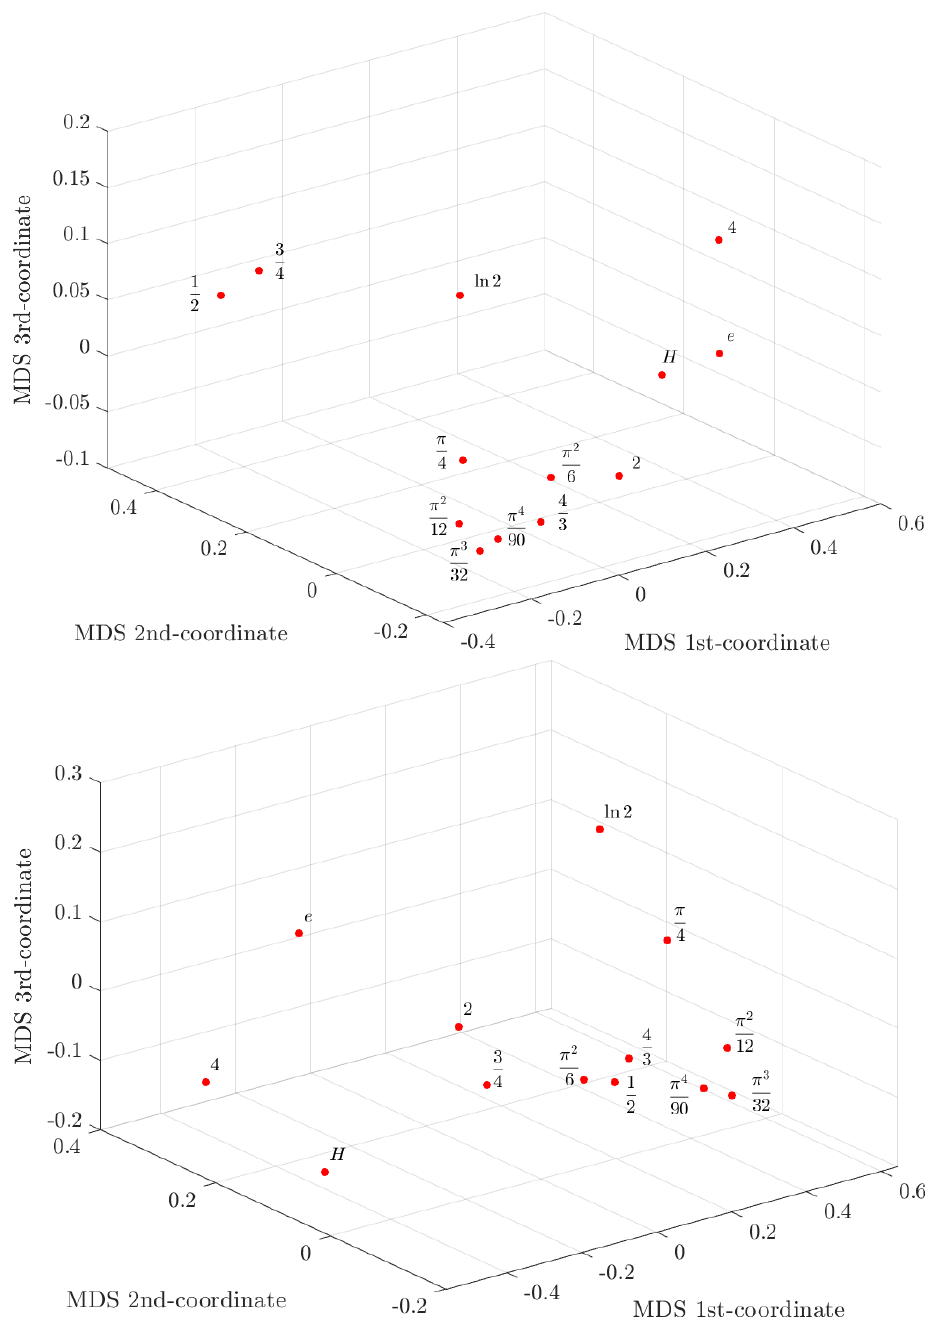
Figure 3. MDS loci of the numerical series S i , i = 1, . . . ,13, produced by the Jaccard ( top ) and ArcCosine ( bottom ) distances, d Ja and d Ac , for r =